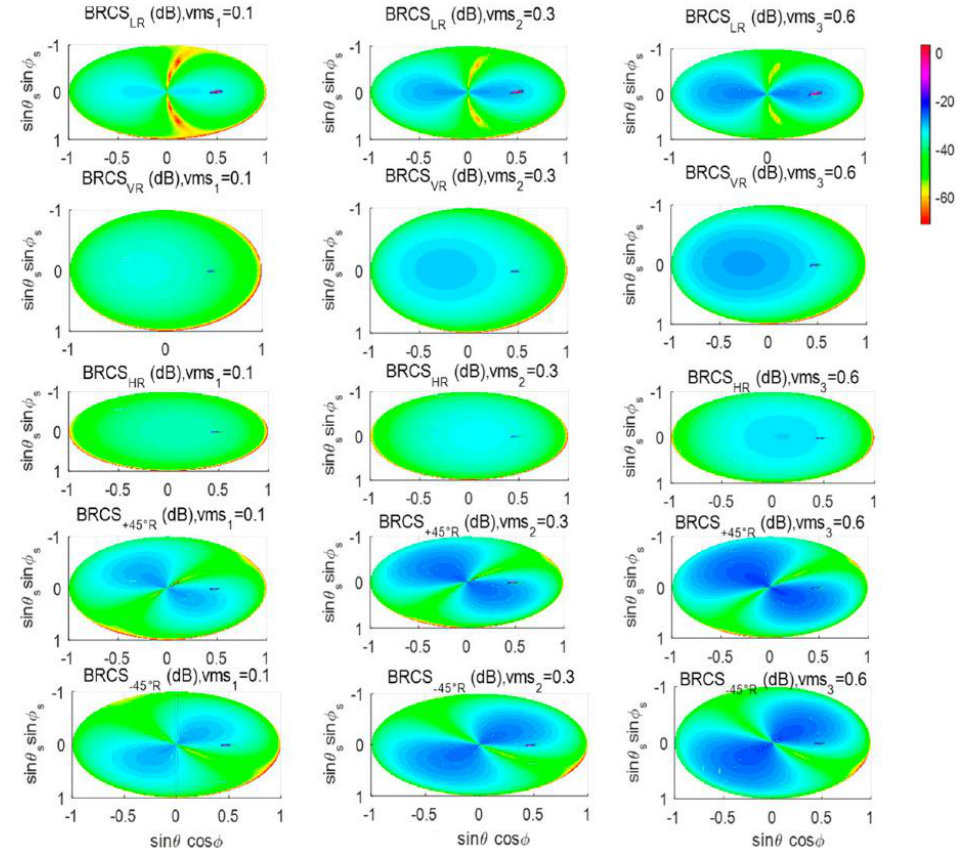
Figure 3. Bistatic scattering properties at various polarizations. vms is the volumetric moisture content of the soil. The x-axis and y-axis indicate the different scattering geometries. To obtain spaceborne information, we employed LAGRS to simulate the final DDM output. During our simulations, the integration areas were set as defined in Table 2, where X_range and Y_range are the spatial integral range in the x direction and y direction, respectively, and X_interval and Y_range are the spatial integral interval in the x direction and y direction, respectively. Our objective was to obtain the polarization effects; therefore, we kept other influenc- ing factors constant. The volumetric soil moisture content was set Table 2. Integration area settings.